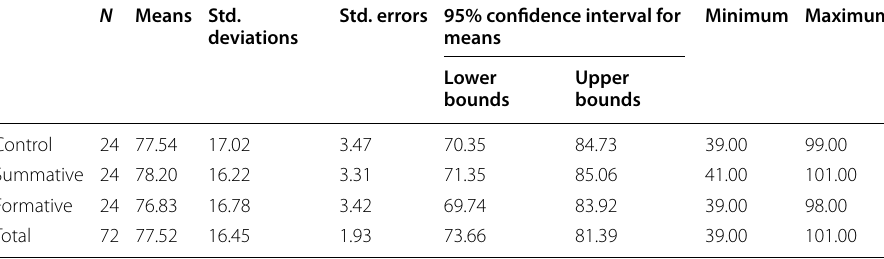
Table 6 Descriptive statistics of the three groups on the self-regulation pre-tests N Means Std. Std. errors 95% confidence interval for deviations means